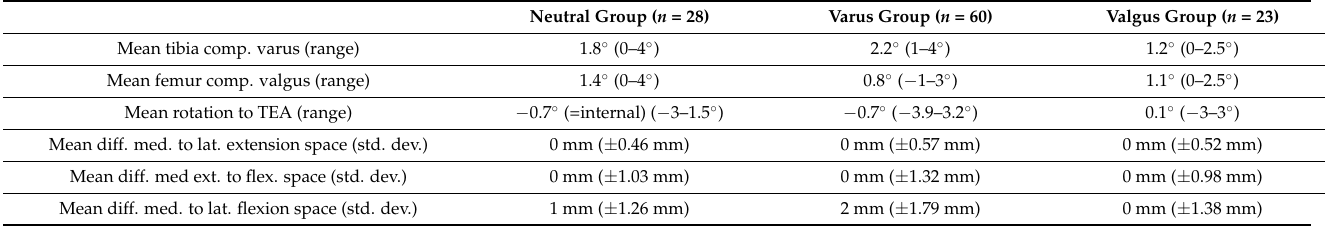
Table 4. Final set component alignment intraoperatively and final gap symmetry. Neutral Group ( n = 28)